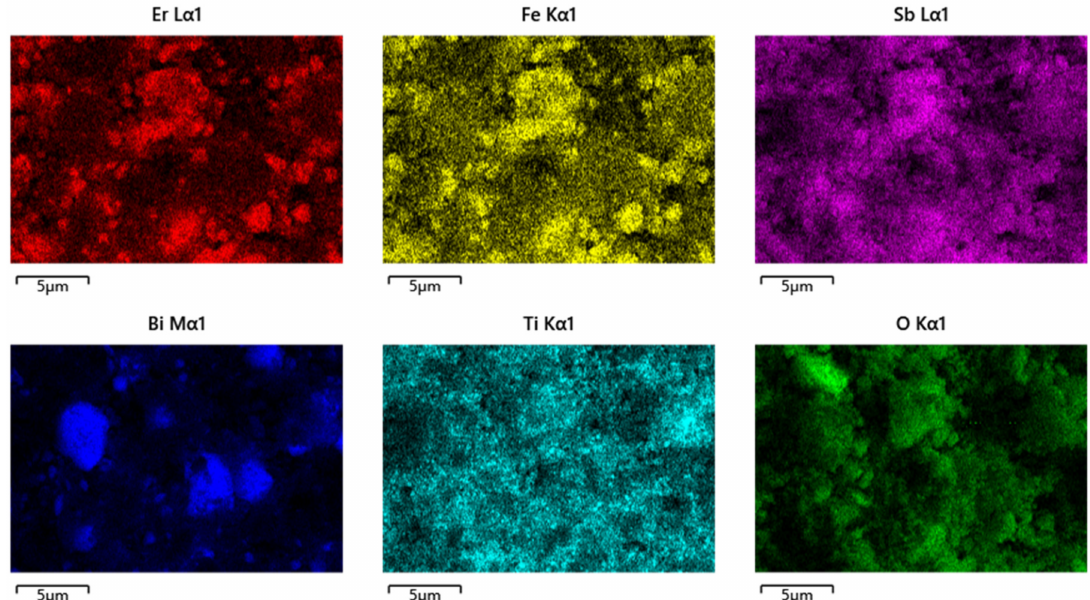
Figure 10. EDS elemental mapping of EBHP (Er, Fe, Sb, O from Er 2 FeSbO 7 and Bi, Ti, Sb, O from BiTiSbO 6 ).